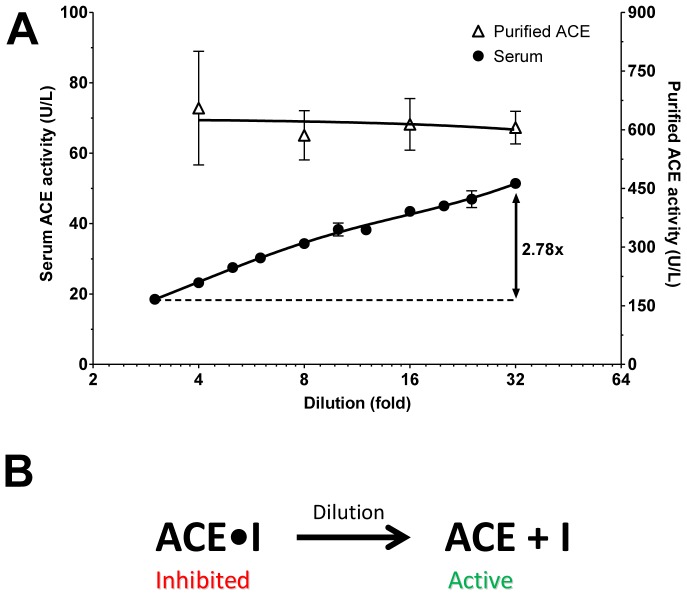
Endogenous inhibitor masks ACE activity in human sera.Effects of dilution on the ACE activity were tested on purified renal ACE (Purified ACE) and human serum (A). Plots were fitted by means of linear regressions in case of purified ACE while nonlinear regression was used in case of serum ACE (indicated by the solid lines), while symbols denote the means ± SEM of at least 3 independent determinations. The increase of specific serum ACE activity (2.78-fold) upon dilution is also indicated. The hypothesis proposed to explain these findings is that an endogenous inhibitor is present in the sera, which inhibits ACE at low dilution and then dissociates at higher dilution, unmasking ACE activity (B).